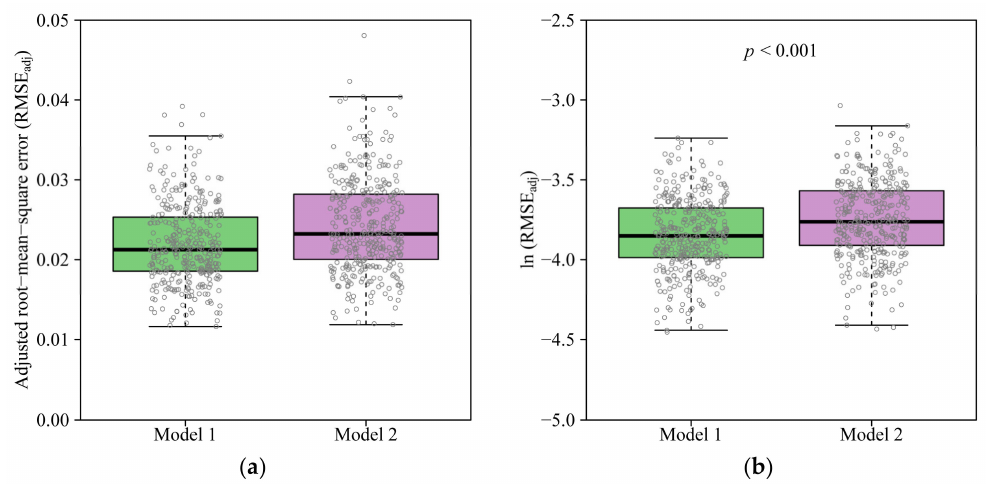
Figure 3. Comparison of adjusted root-mean-square errors ( a , RMSE adj , Equation (7)) and their ln-transformations between Models 1 and 2 ( b ). The thick horizontal lines represent median values in the boxes; a box’s body length represents the difference between the 3/4 quantile and the 1/4 quantile; whiskers represent 1.5 times the box’s body length or maximum (or minimum) values; and the small gray open circles represent the distribution of data points. The ln-transformed values in ( b ) were compared by a paired sample t -test.